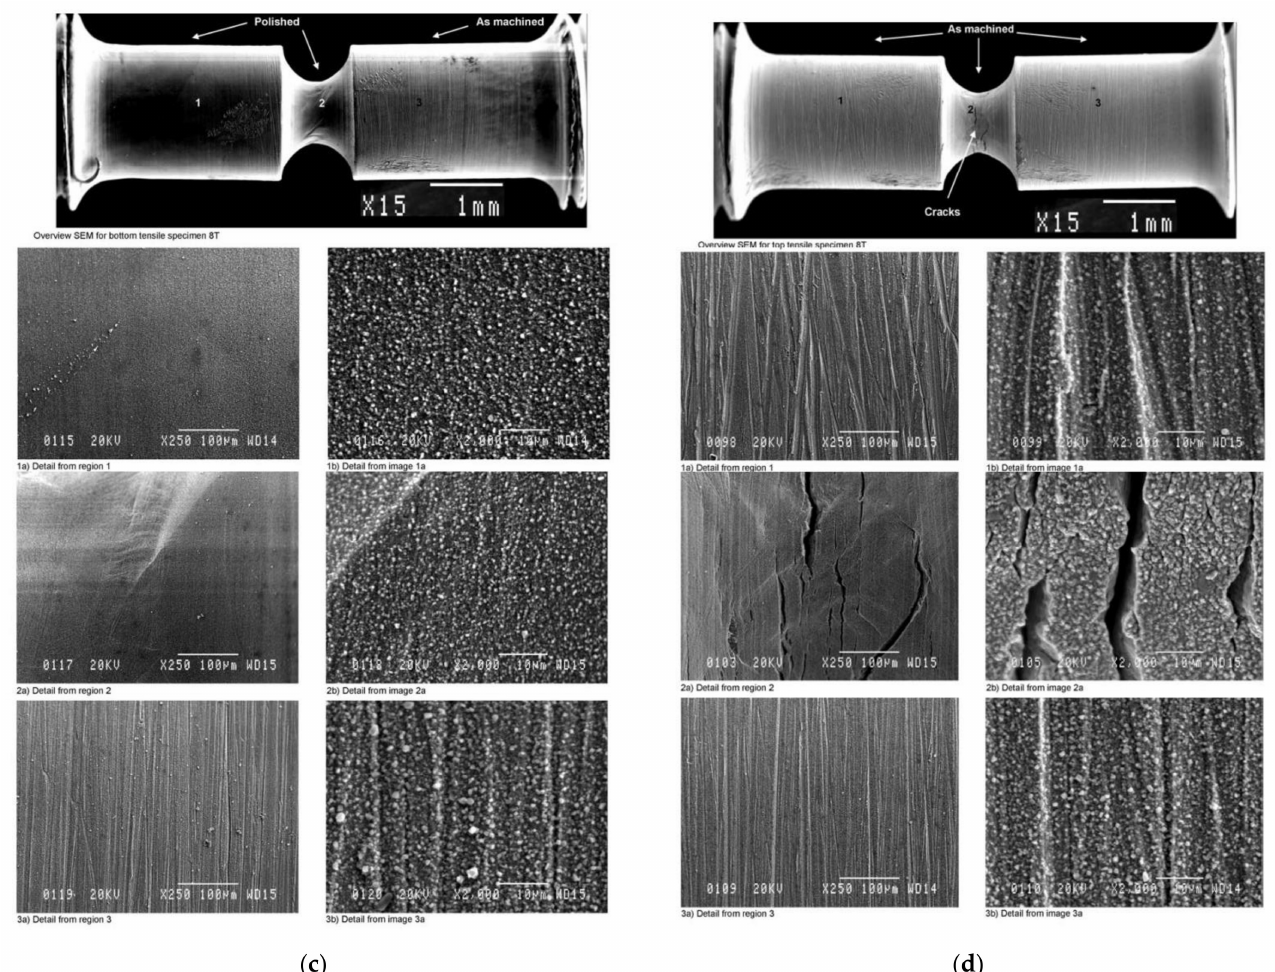
Figure 14. ( a ) SEM overview and details at locations 1, 2 and 3 for 316L SS tensile specimen 3T-5 (with polished regions) with 22 full power day exposure; ( b ) SEM overview and details at locations 1, 2 and 3 for 316L SS tensile specimen 3T-6 (as-machined) with 22 full power day exposure; ( c ) SEM overview and details at locations 1, 2 and 3 for 316LN SS tensile specimen 8T-15 (with polished regions) with 107 full power day exposure; ( d ) SEM overview and details at locations 1, 2 and 3 for 316LN SS tensile specimen 8T-16 (as-machined) with 107 full power day